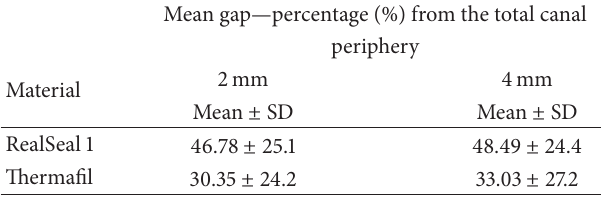
Table 2: The mean percentage gap observed in RealSeal 1 and Thermafil at 2 mm and 4mm sections away from the root